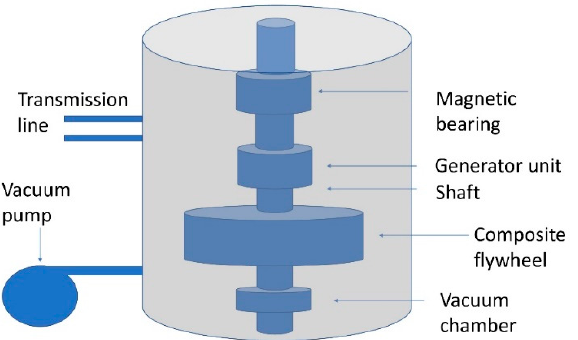
Figure 12. Representation of the components of a flywheel energy storage system.